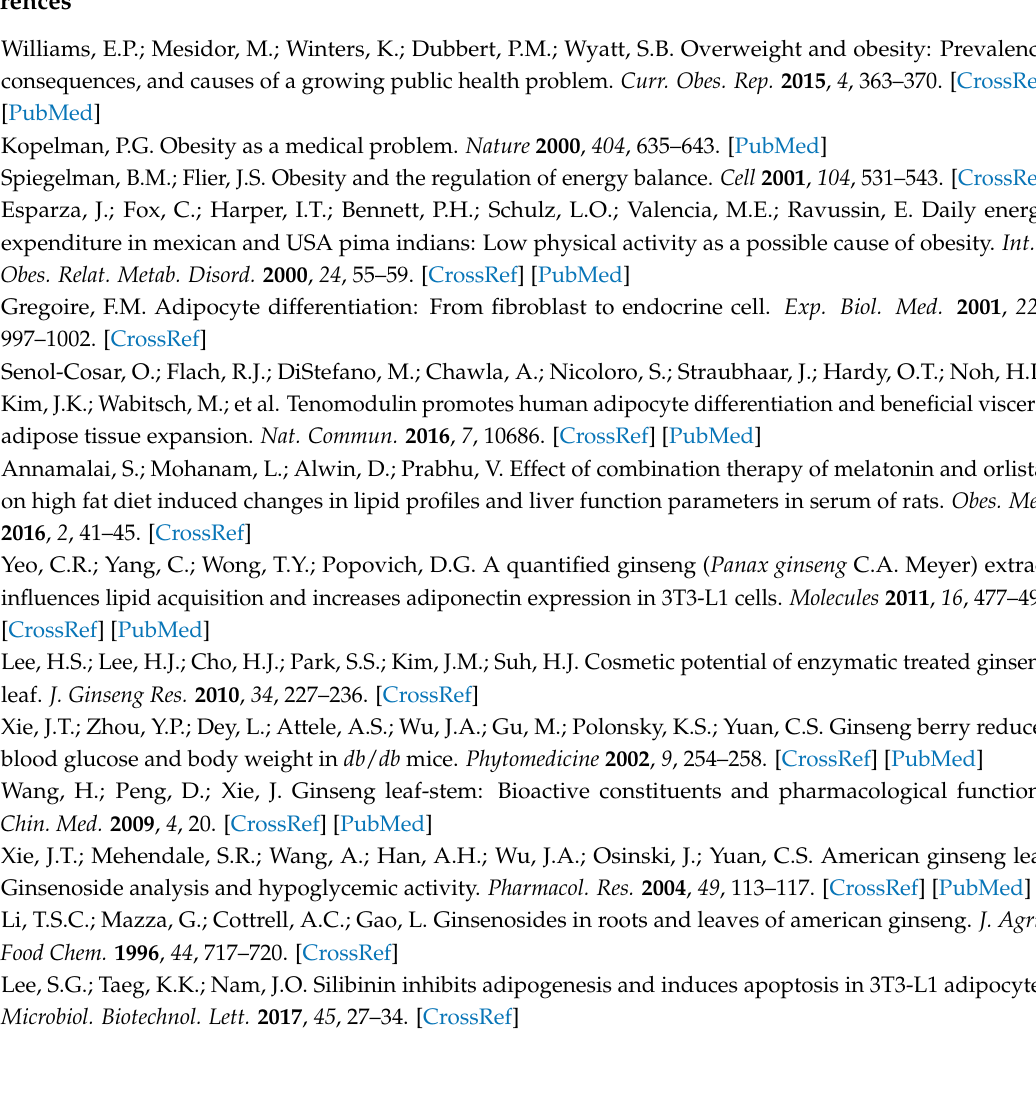
Table S1: The composition of experimental diets; Table S2: Sequences and accession numbers for primers used in RT-PCR; Table S3: Plasma biochemical values in male rats; Table S4: Effects of green leaf (GL) and dried leaf (DL) on the weights of liver, kidney, heart, spleen, pancreas, and muscle tissues in male rats. Author Contributions: Designed article: J.-O.N., M.-H.J. and T.R.K. Conducted research and analyzed data: S.G.L., Y.J.L. and J.-O.N. Wrote paper: S.G.L., J.-O.N. Conflicts of Interest: The authors declare no conflict of